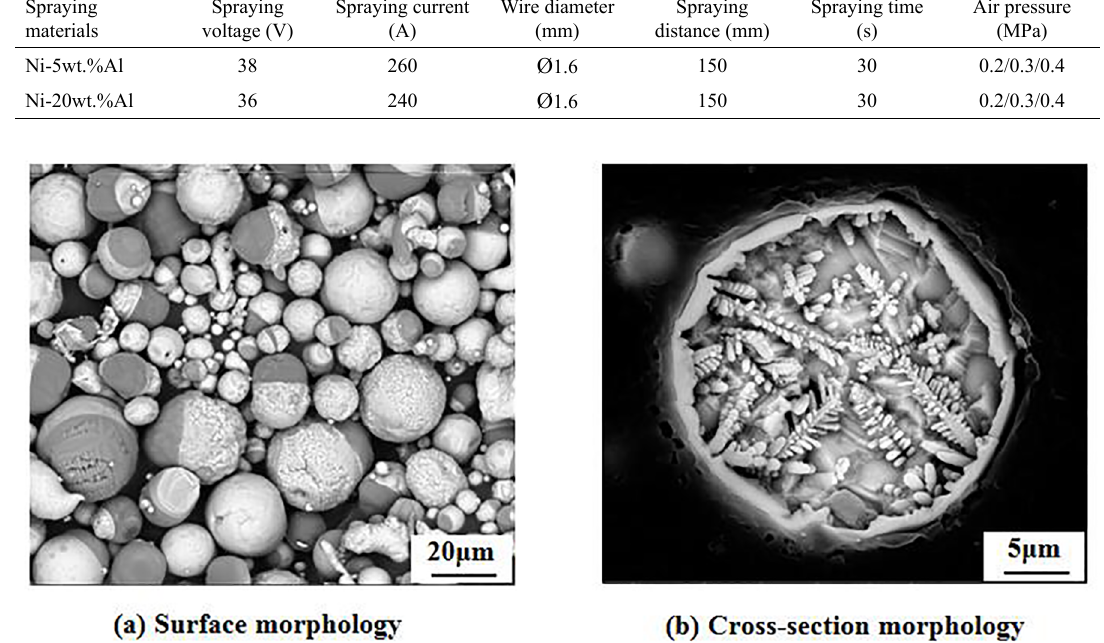
Figure 13. SEM morphology of Ni-Al powder for surface morphology (a) and inner cross-section morphology